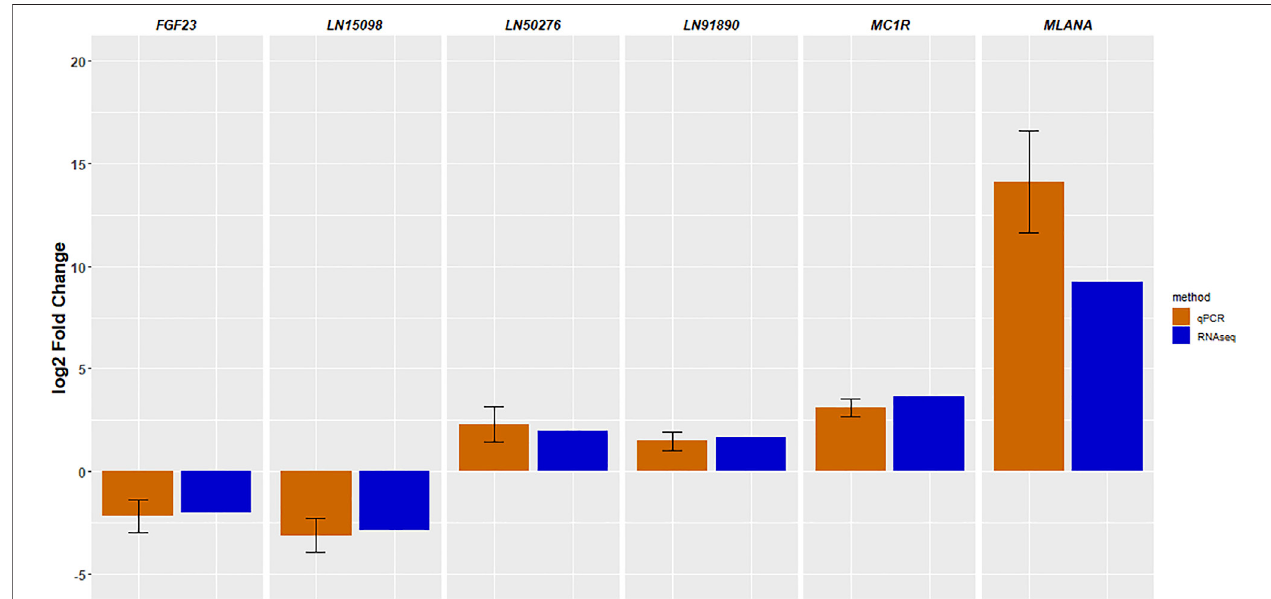
FIGURE 5 | Validation of RNA-sequencing results by quantitative RT-PCR. The data are shown as the mean ± standard